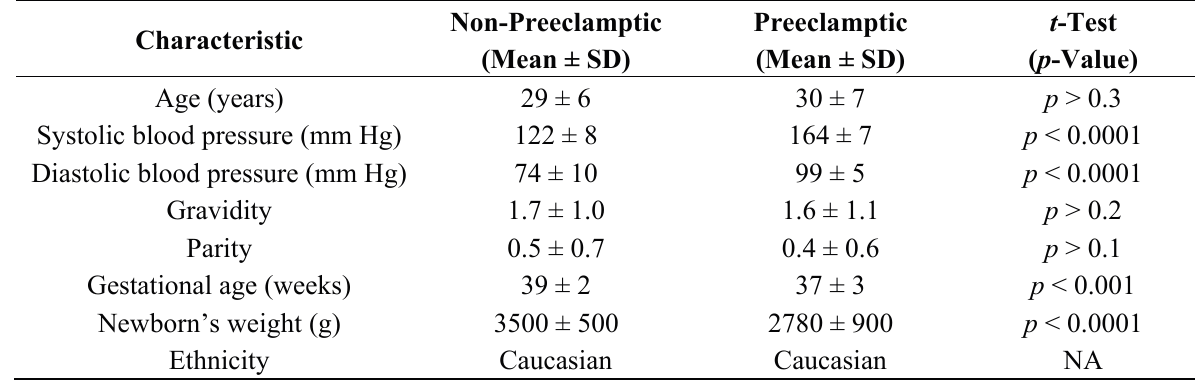
Table 1. Sociodemographic and clinical profiles of the preeclamptic vs. non-preeclamptic cohort. Characteristic